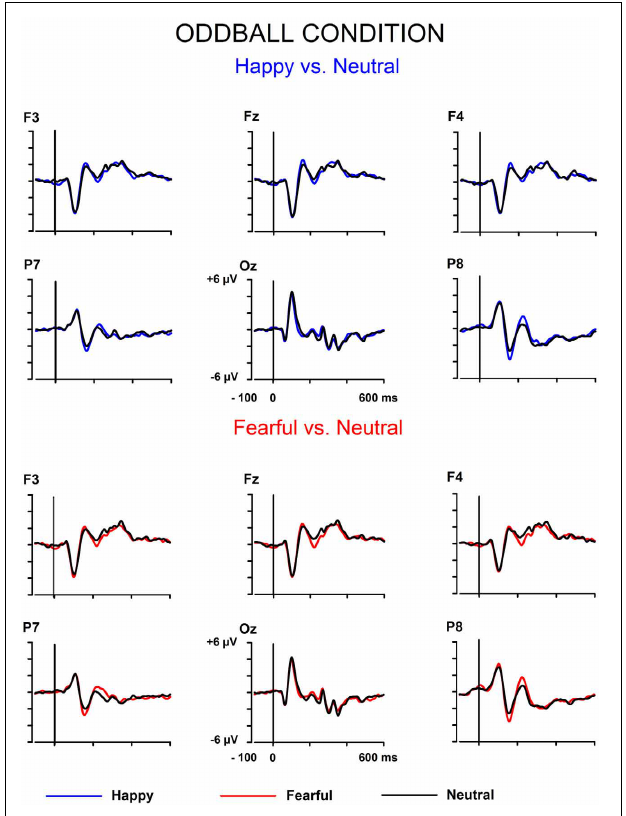
FIGURE 1 | Grand-averaged ERPs in the oddball condition. Raw ERPs to happy and fearful deviant faces and to the neutral standard faces immediately preceding them. Stimulus onset at time 0.